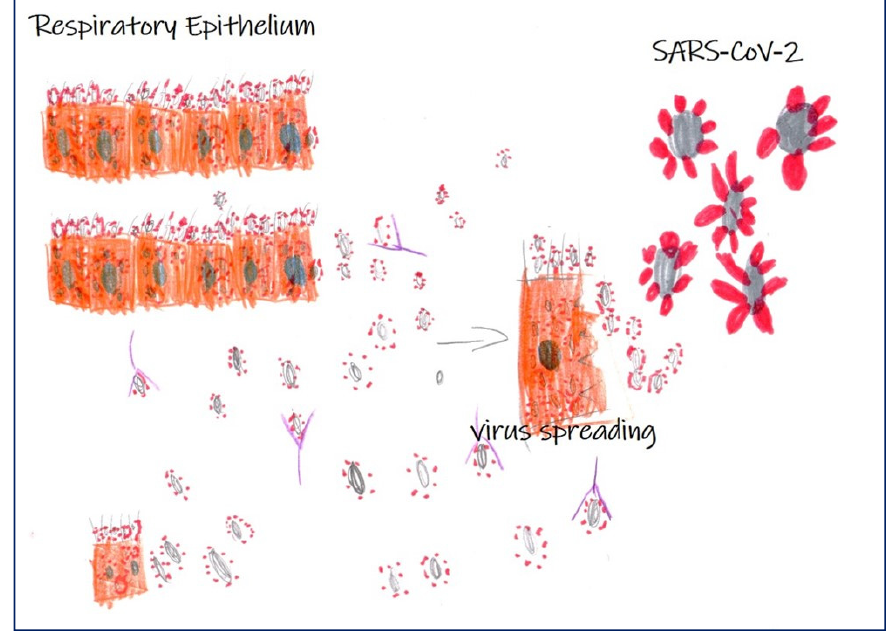
Figure 1. Scheme of severe acute respiratory syndrome coronavirus-2 (SARS-CoV-2) infection in respiratory epithelium. Image shows infection of SARS-CoV-2 in respiratory epithelium, virus spreading, and the antibody response (Martina Gioia Simeca, 5-year-old).